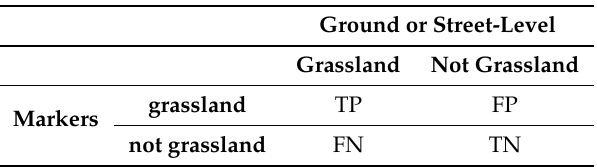
Table 3. Markers’ assessment through True Positive (TP), False Positive (FP), False Negative (FN) and True Negative (TN)